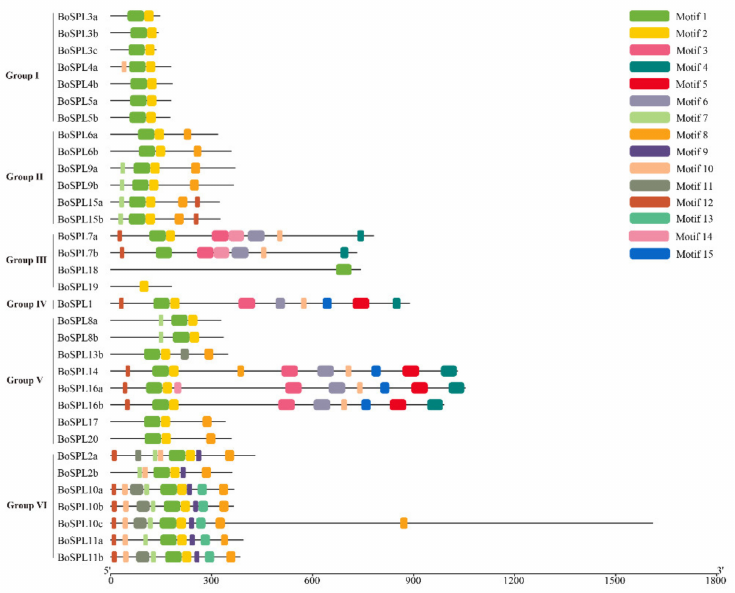
Figure 5. SPL proteins motifs. The motifs are shown as colored boxes. The scale on the bottom may be used to estimate the length of the motif (unit: amino